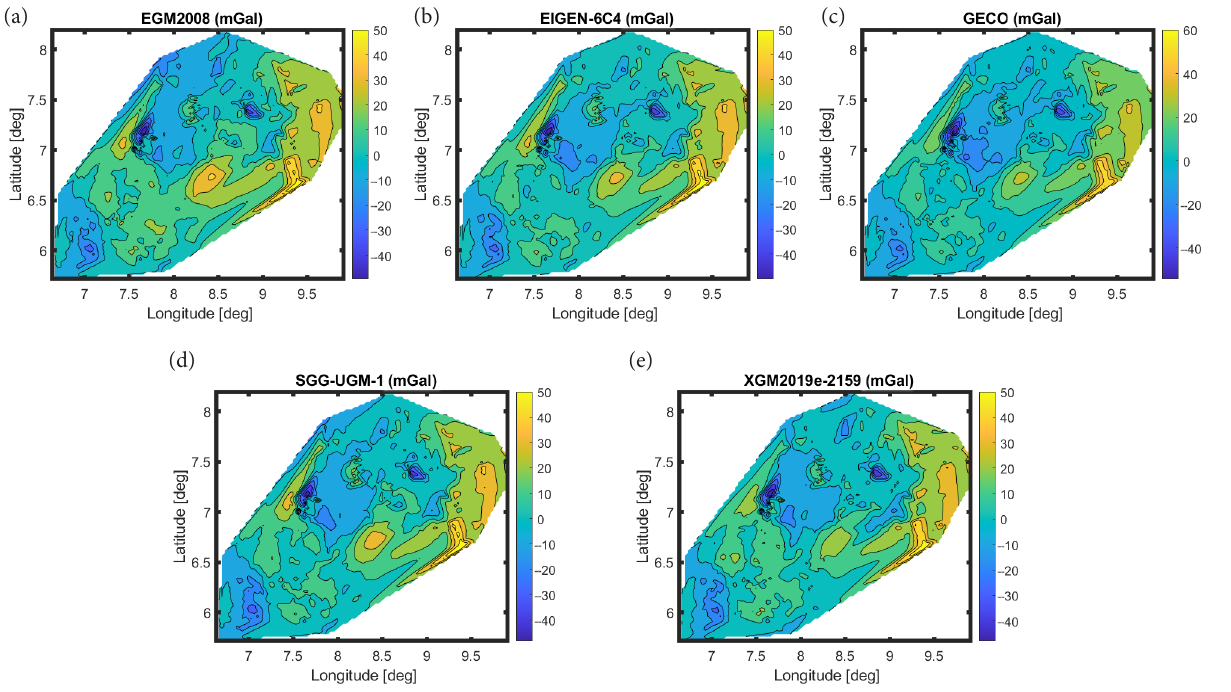
Figure 6. Differences between ground-based and GGM-derived Bouguer gravity anomalies: